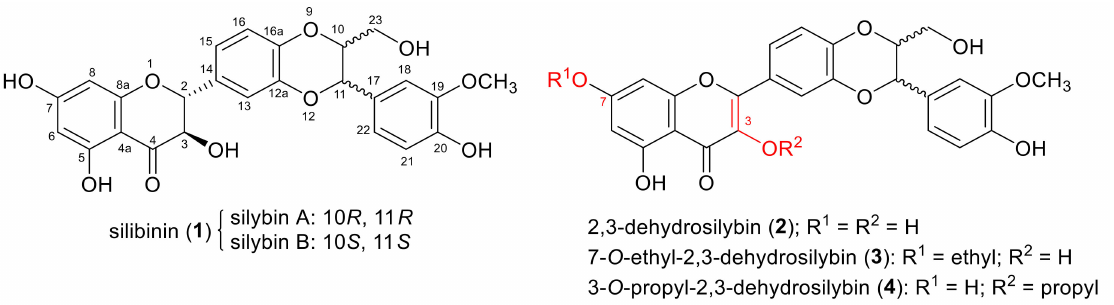
Figure 1. Structures of silibinin and